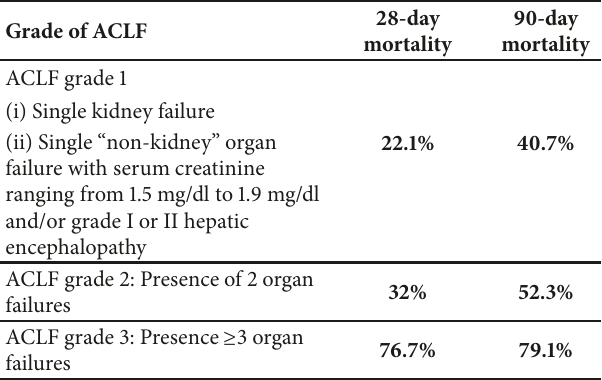
Table 1: Definition and prognosis of